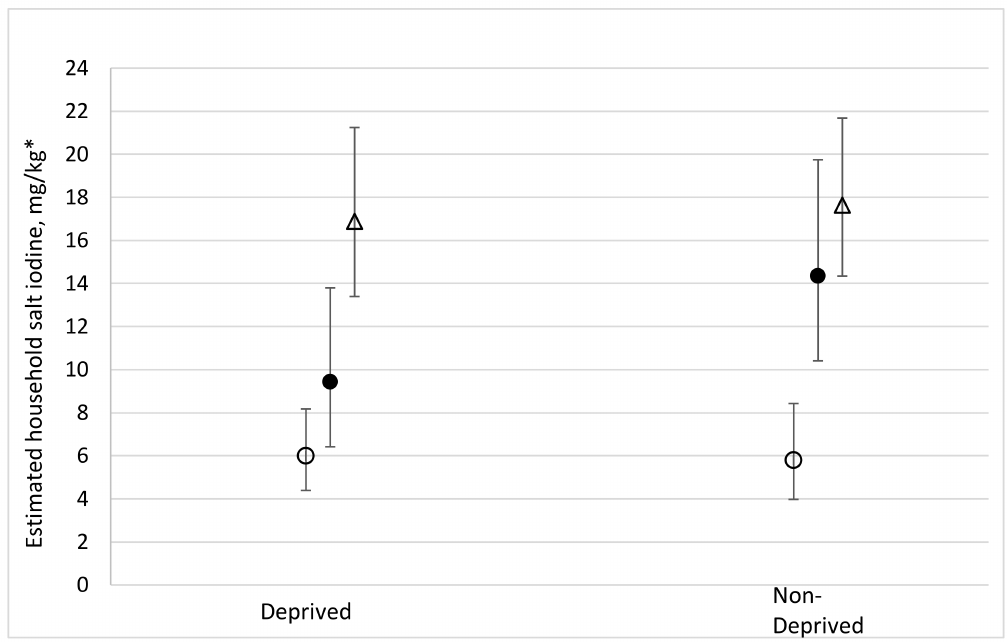
Figure 2. Multiple variable regression analysis including interaction with strata in Senegal; Rural-salt-producing, Rural-non-salt-producing, ∆ Urban; to estimate household salt iodine (cid:35) (mg/kg) according to household multi-dimensional poverty index (MPI) (living standards). * Adjusted estimates with 95% confidence intervals for salt iodine content, back-transformed from a log-linear model adjusting for: urban/rural residence, MPI components (education and health/nutrition), awareness of iodised salt, awareness of iodine deficiency, salt brand, iodine label or logo on packaging, respondent looked for iodised salt at purchase, and grain